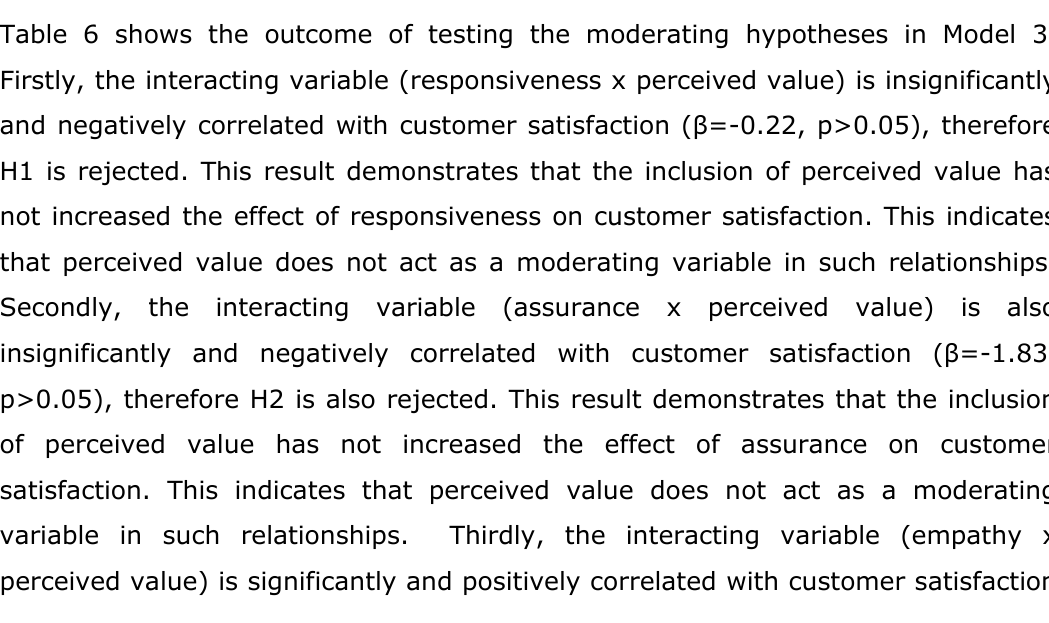
Table 6: “Results for hierarchical regression analysis with perceived value as the moderating variable and customer satisfaction as the dependent